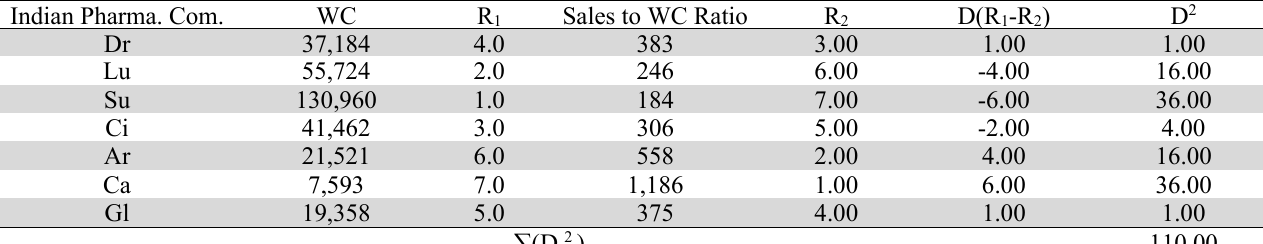
Relational co-movement of working capital and sales to working capital ratio of selected leading pharmaceutical companies of India (2013-18) Indian Pharma. Com.